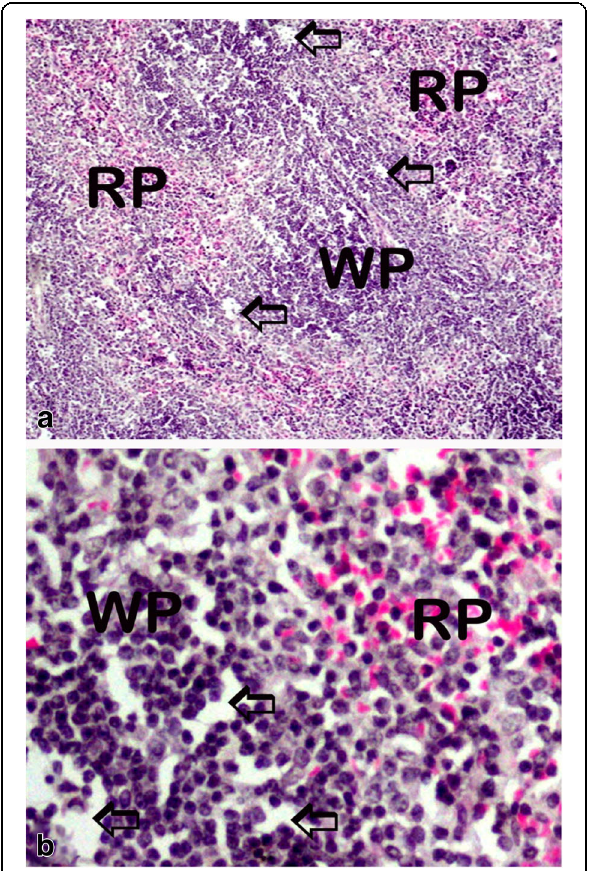
Fig. 4 Histological sections of spleen from the mice in G11 treated with SE of C. swynnertonii (SE, 1500 mg/kg), 8 hourly intervals for three days consecutively. There are white foci of variable sizes in the white and red pulp ( open arrows ) in ( a ). Pyknosis of lymphocytes in some of the white foci is evident in ( b ). Magnifications, ( a ) 100 x; ( b ) 400